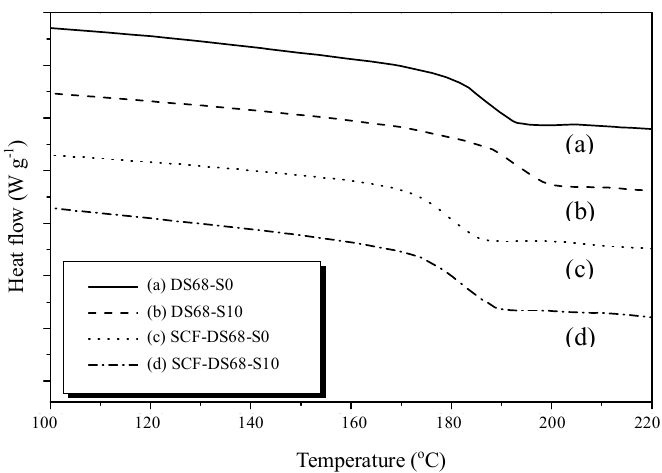
Figure 9. Effects of supercritical CO 2 fluid (SCF) treatment on sPEEK/SiO 2 composite membranes. T g has been decreased on the DSC curves.